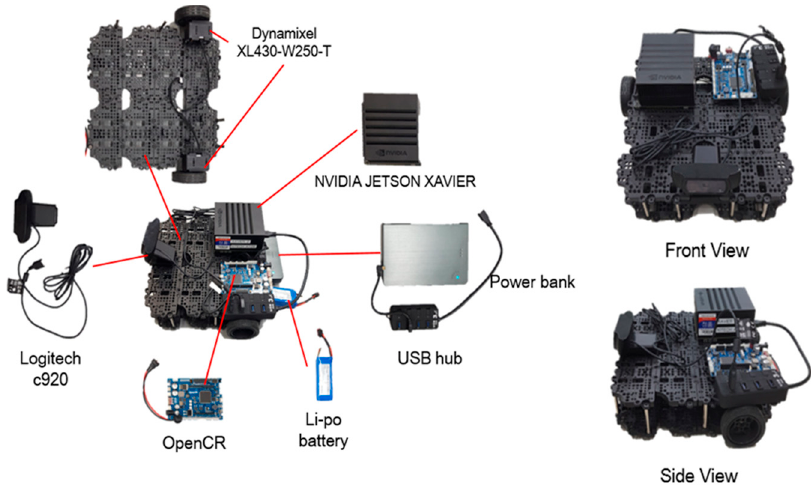
Figure 6. Mobile Figure 6. Mobile robot. Figure 6. Mobile robot.